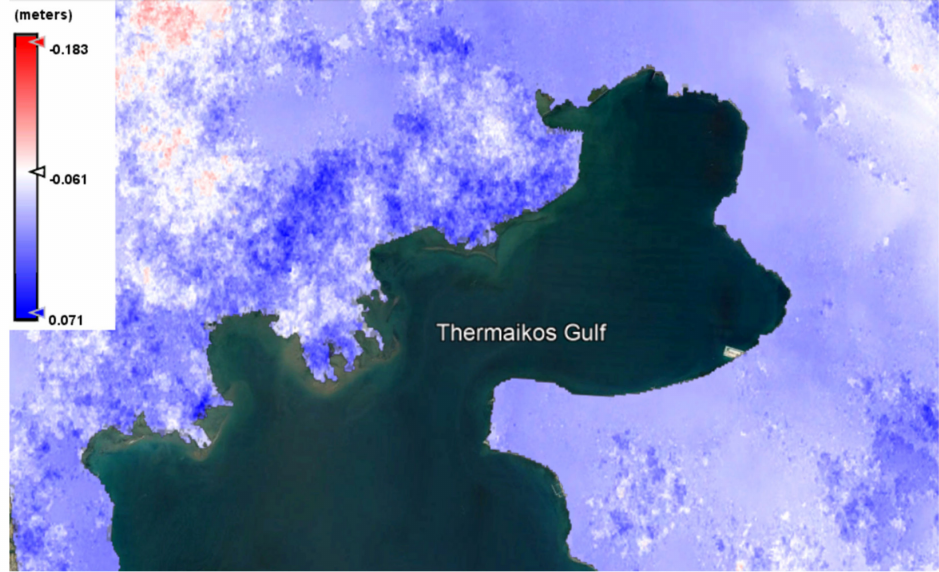
Figure 17. A sample land subsidence velocity map of the study area for the reference years of 2014 to 2016.